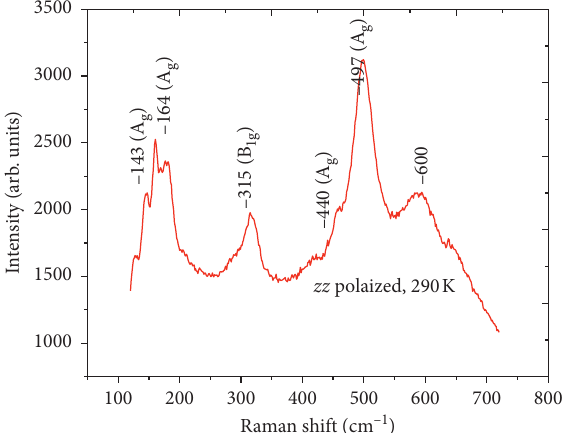
Figure 5: zz polarization Raman spectrum of (110)-oriented Co doped PBCO thin film.